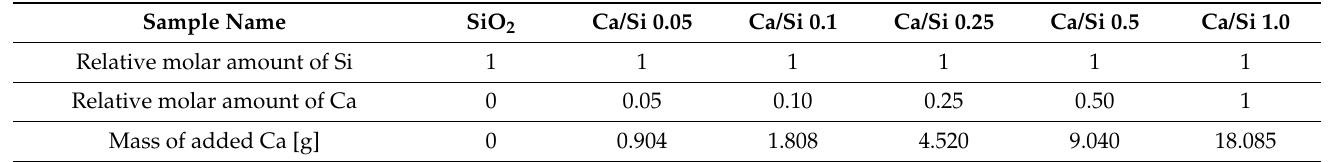
Table 1. Composition and labeling of the studied systems and the amount of metallic calcium